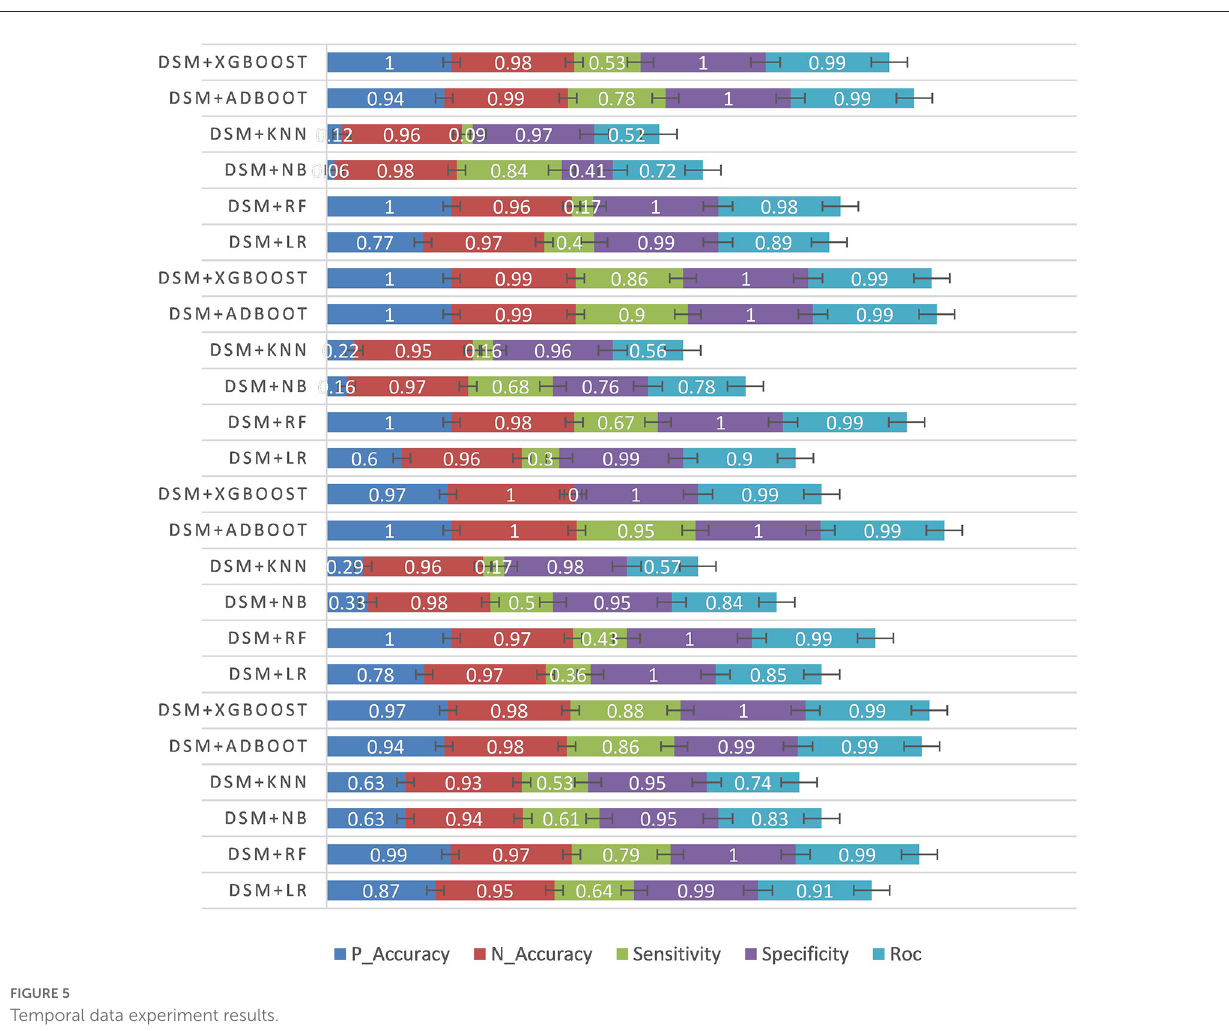
FIGURE5 Temporal data experiment